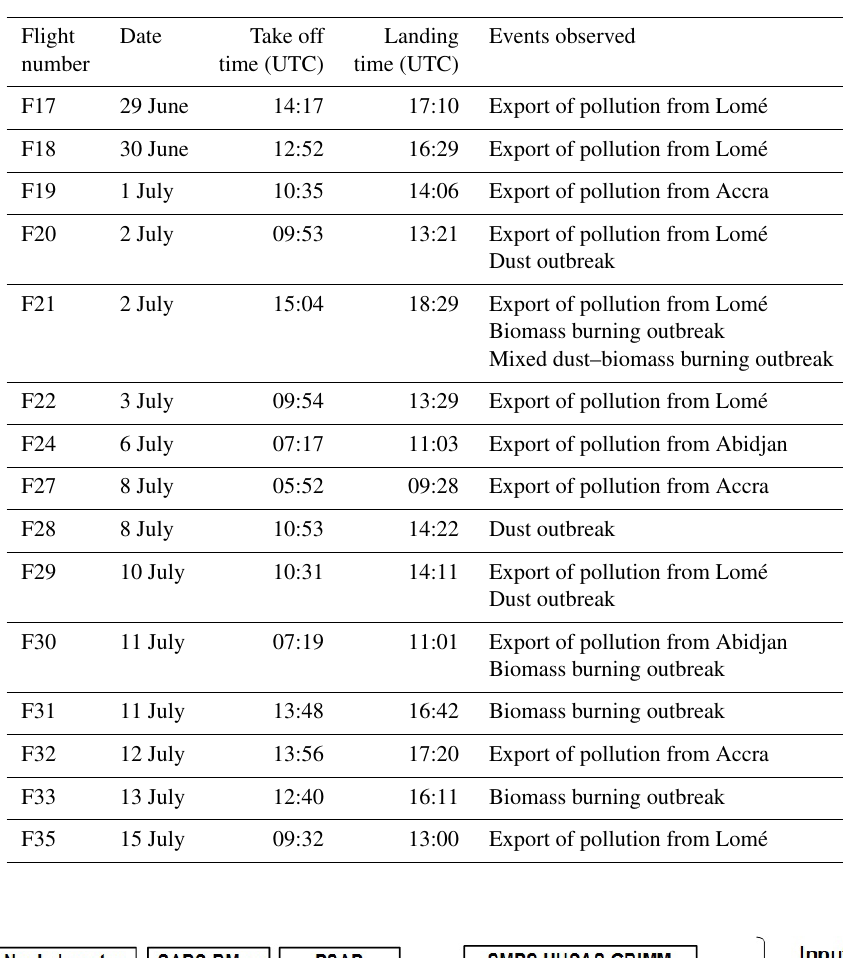
Table A1. Summary of flight information. All flights were conducted during 2016.